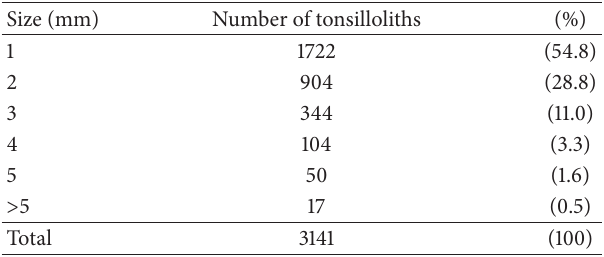
Table 1: Number of tonsilloliths per palatine tonsil. Table 2: Distribution of the size of palatine tonsilloliths.